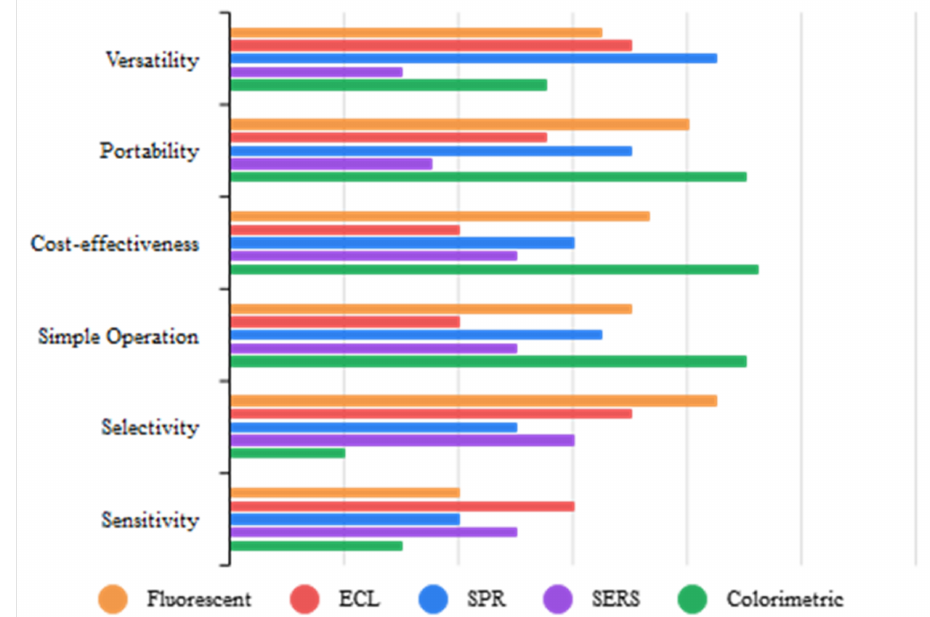
Figure 1. Comparison of optical methods. Table 1. Optical biosensors for CA-125